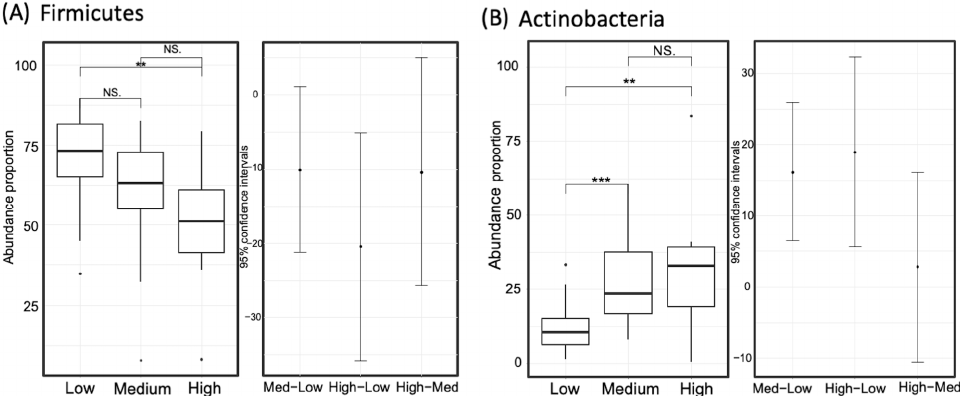
Figure 6. Comparison of the relative taxon abundance of the phyla Firmicutes (panel A ) and Actinobacteria (panel B ) among the three gamma-aminobutyric acid (GABA) groups (high, medium, and low). Significance codes: <0.001 ***, <0.01 **, <0.1 “NS”.